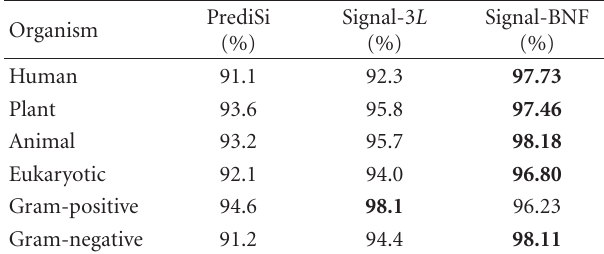
Table 9: Compare our approach’s prediction accuracy for secretory proteins from nonsecretory proteins to other approaches.